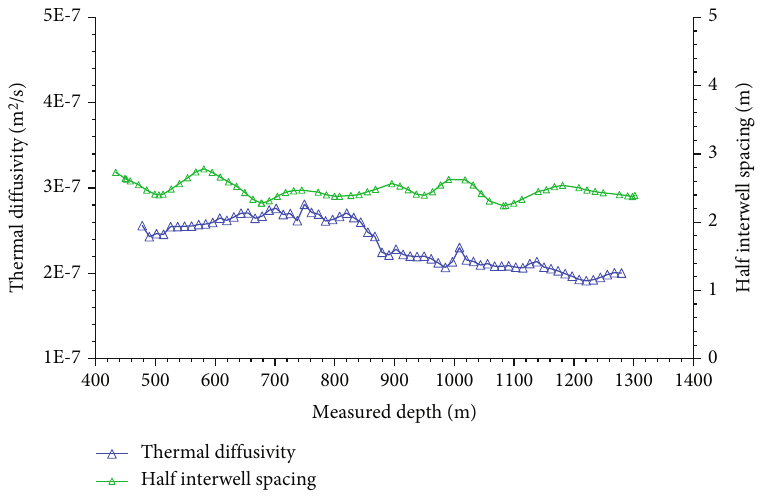
Figure 8: Comparison curve of thermal di ff usivity and half-interwell spacing along the horizontal section.